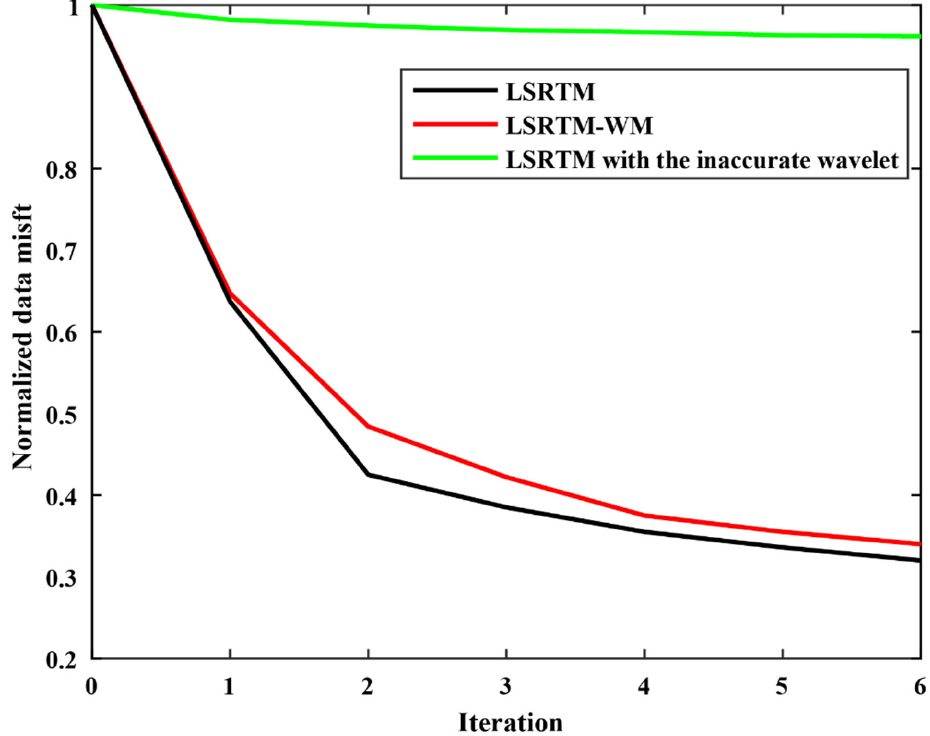
Figure 12. Convergence curves for LSRTM (Figure 9a), LSRTM-WM (Figure 10b), and LSRTM with the inaccurate wavelet (Figure 11) are indicated by the black, red, and green lines, respectively.